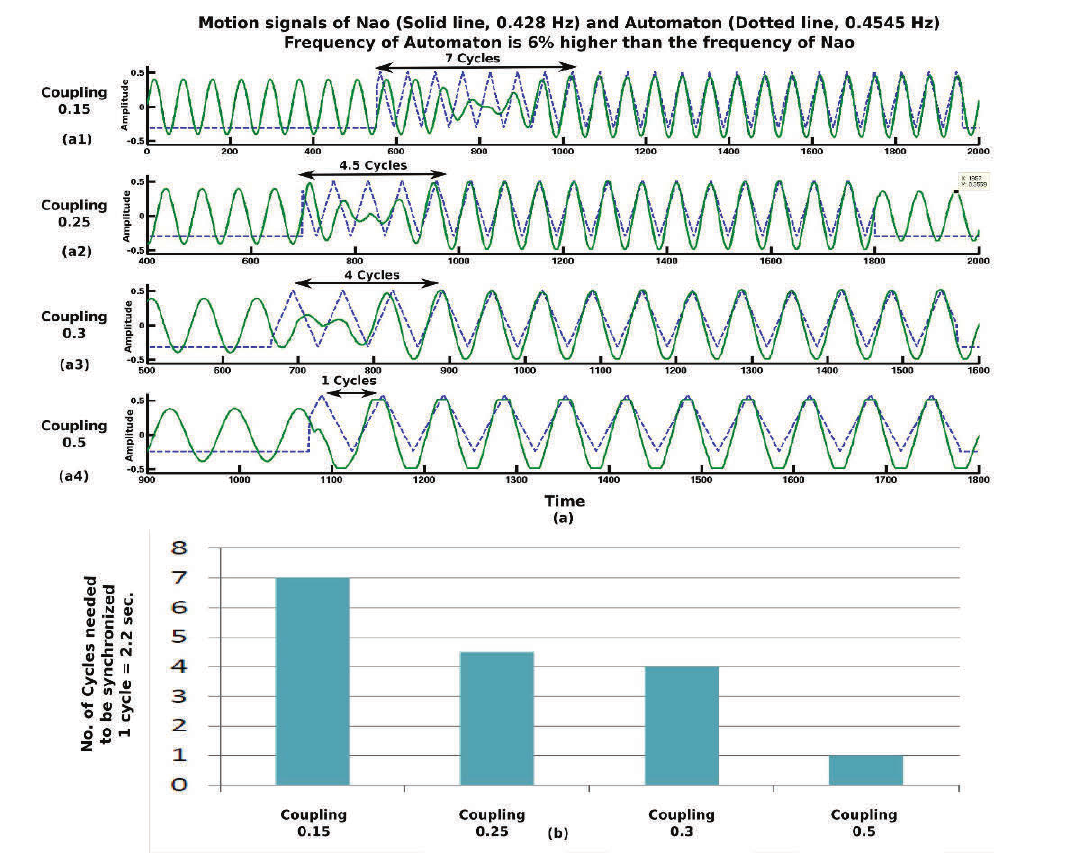
Figure 5. (a) and (b) detail the relationships between the quantity of coupling energy and the synchronization time of two agents. Figure 5(a) shows the motion signals of Nao (solid line, 0.428 Hz) and Automaton (dotted line, 0.4545 Hz), it can be observed that with low scaling for coupling energy (0.15) two agents take a long time (4.5 cycles) to be synchronized (fig 5(a1)). As the scaling factor for coupling energy increases to 0.25 and to 0.3, synchronization time decreases to 4.5 cycles to 4 cycles respectively (fig 5(a2,a3)). Further increases in coupling energy (0.5) reduce the synchronization time to only 1